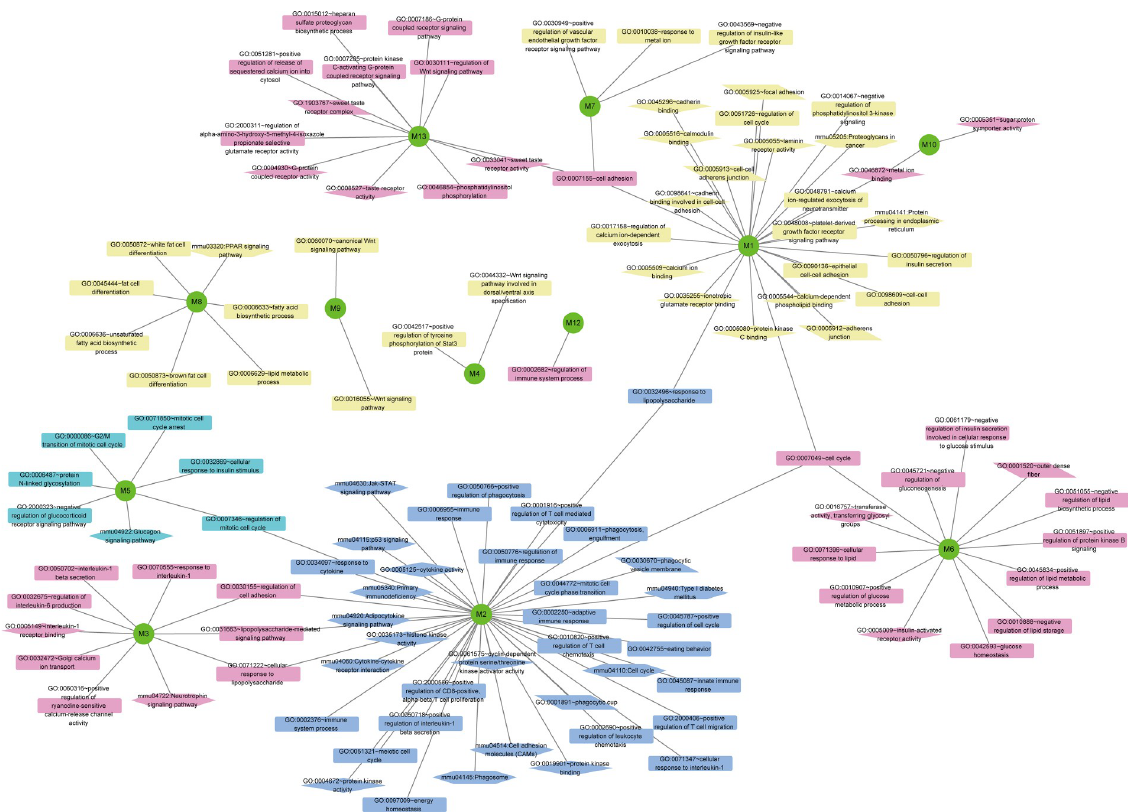
Fig 5. Functional and pathway enrichment of potential disease-causing modules. The green circle represents module, the rectangle represents the biological process of the GO function, the diamond represents the molecular function of the GO function, the parallelogram represents the cellular composition of the GO function, and the hexagon represents the KEGG pathway. Blue represents a type I diabetes- related functional pathway, cyan represents a type II diabetes-related functional pathway, yellow represents a major vascular disease-related functional pathway, and red represents a diabetic vascular lesion complex